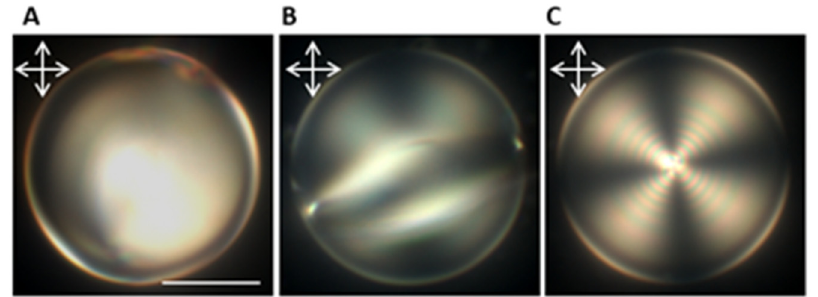
Figure 5. Reflection mode POM images of bipolar to radial ordering transition in a 50 µm nematic droplet in the presence of DLPC amphiphiles. It transient from bipolar ( A ) to intermediate ( B ) and finally radial configuration ( C ) (scale bar = 20 µm).